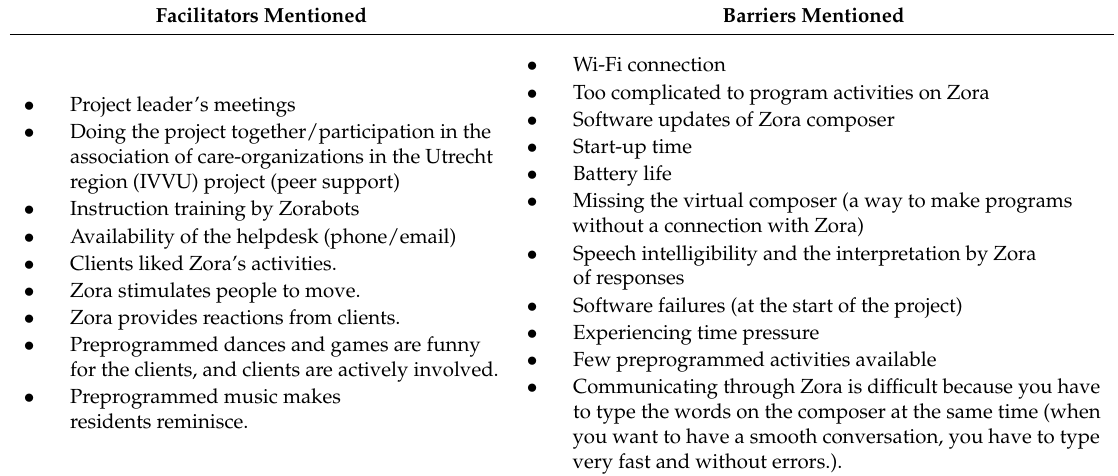
Table 2. A summary of the facilitators and barriers regarding using Zora in 2016.